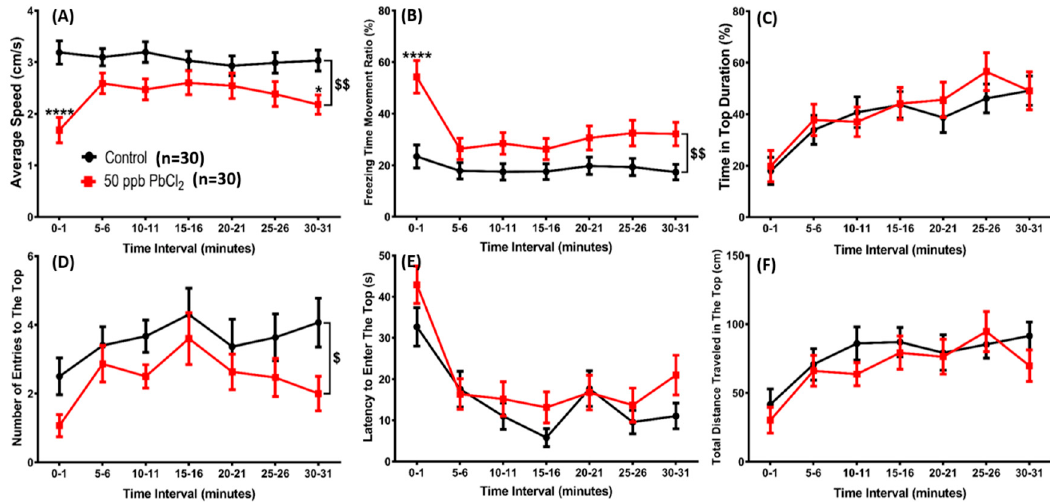
Figure 3. Comparison of behavioral endpoints in the novel tank exploration test among 30-day 50 ppb PbCl 2 -exposed groups and a control group. Six parameters were evaluated: ( A ) average speed, ( B ) freezing time movement ratio, ( C ) time in top duration, ( D ) number of entries to the top, ( E ) latency to enter the top, and ( F ) total distance traveled in the top. Data are expressed as mean ± SEM and analyzed by two-way ANOVA with Sidak’s multiple comparisons test ( n = 30; * / $ p ≤ 0.05, $$ p ≤ 0.01, and **** p ≤ 0.0001).